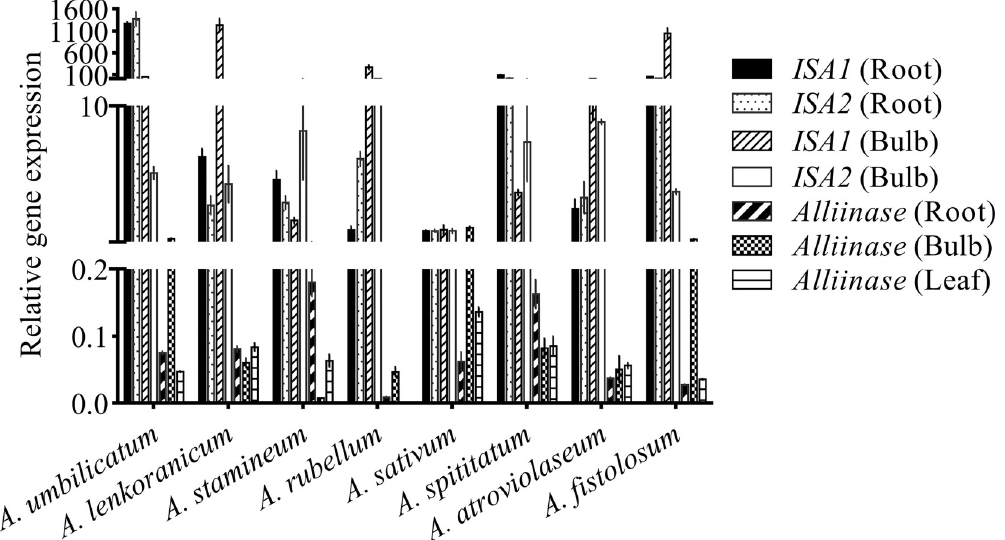
Fig 5. Relative expression of iso - alliinase gene ( alliinase , ISA1 and, ISA2 ) in eight Allium species, including A . sativum , A . stipitatum , A . atroviolaceum , A . fistolosum , A . umbellicatum , A . lenkoranicum , A . stamineum , and A . rubellum . Error bars represent SE (n = 3).